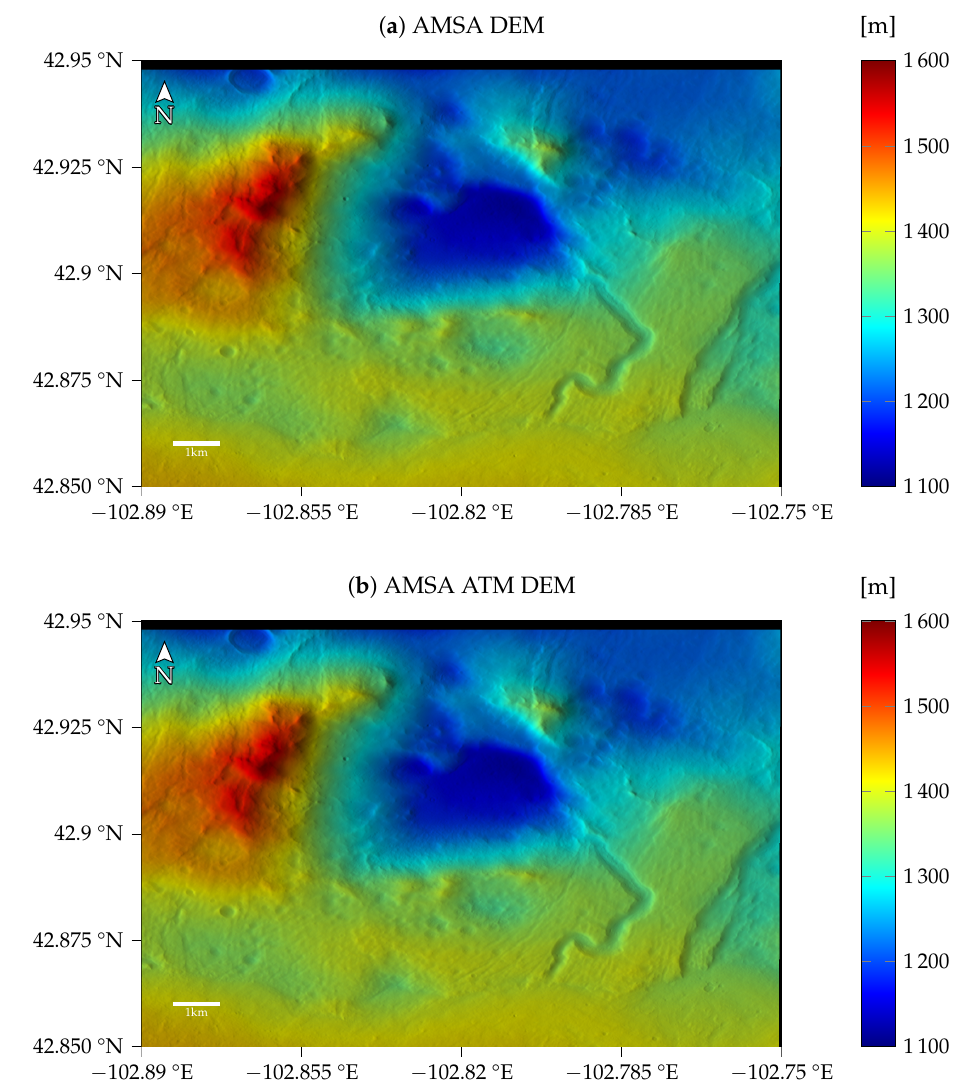
Figure 8. Results for image G20_025970_2217_XN_41N102W ( a ) without and ( b ) with atmospheric compensation. Here, no difference between the two DEMs is visible in the colorcoded shaded DEM. When investigating the profiles in Figures 9 and 10 for heights and slopes, respectively, both are almost identical. Compared to the HiRISE ground truth, a similar level of detail is visible in the profiles, especially highlighted by the slopes. Some slopes, however, seem to be exaggerated by the SfS procedure. There appears to be a mismatch between the absolute heights of the ground truth and the initial DEM in column 1200. This mismatch is also visible in the absolute heights of the SfS results. The RMSE values are similar between the atmospheric and simple AMSA model (see Table 5), but the model with an atmospheric term consistently performs slightly